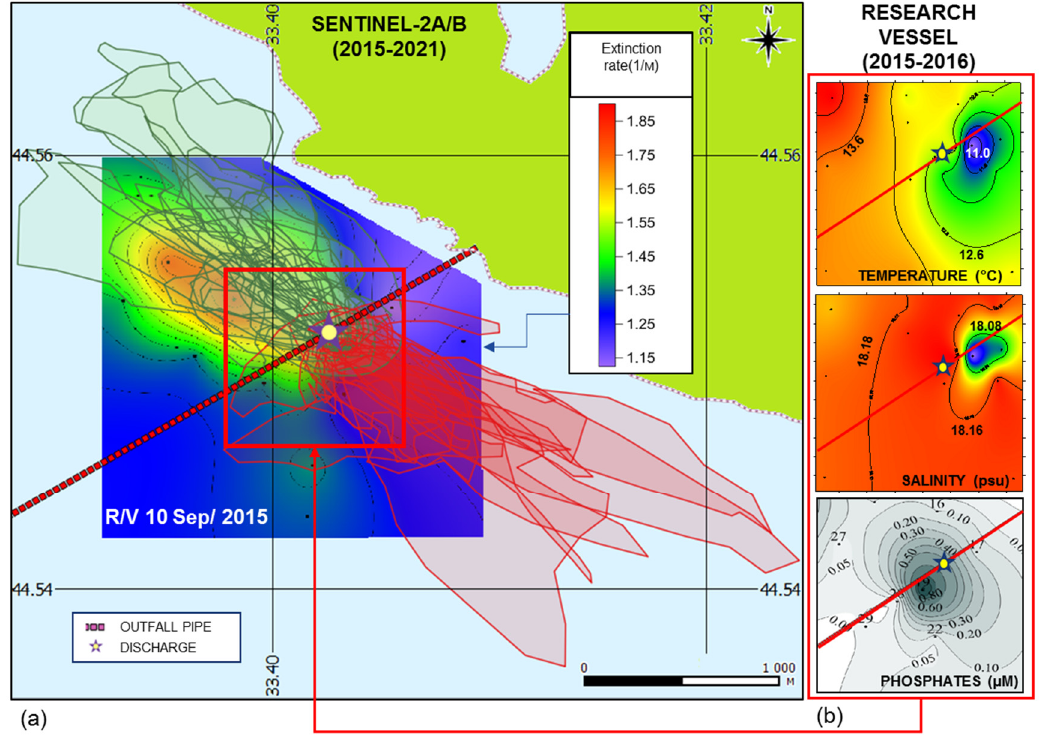
Figure 10. Example comparisons of wastewater plume detection results based on satellite and in situ data processing: ( a ) pollutions according to multispectral Sentinel-2A/B data superimposed on the map of spatial distribution of light attenuation index data; ( b ) example spatial distributions of the temperature, salinity, and phosphate content (shipborne data).